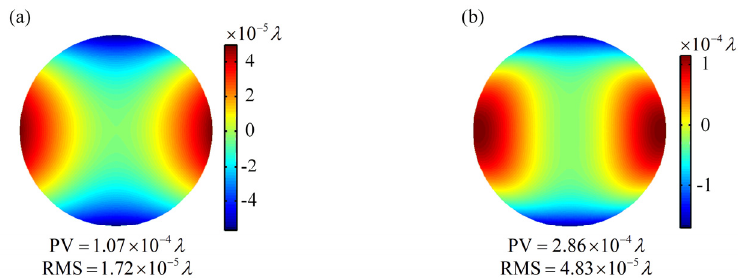
Figure 2. Accuracy of the reference wavefront generated by waveguide RWS when numerical aperture (NA) is ( a ) 0.3 or ( b ) 0.5.